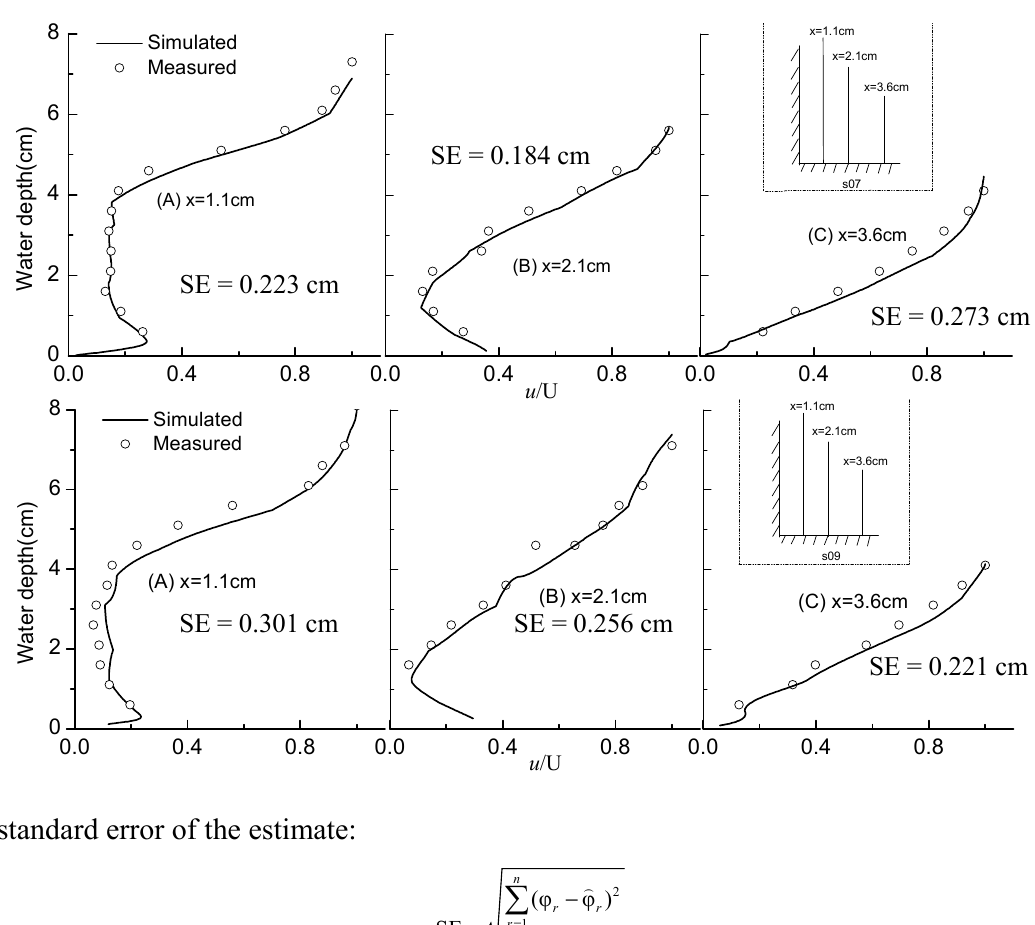
Figure 7. Velocity obtained by simulation and measurement in Chen